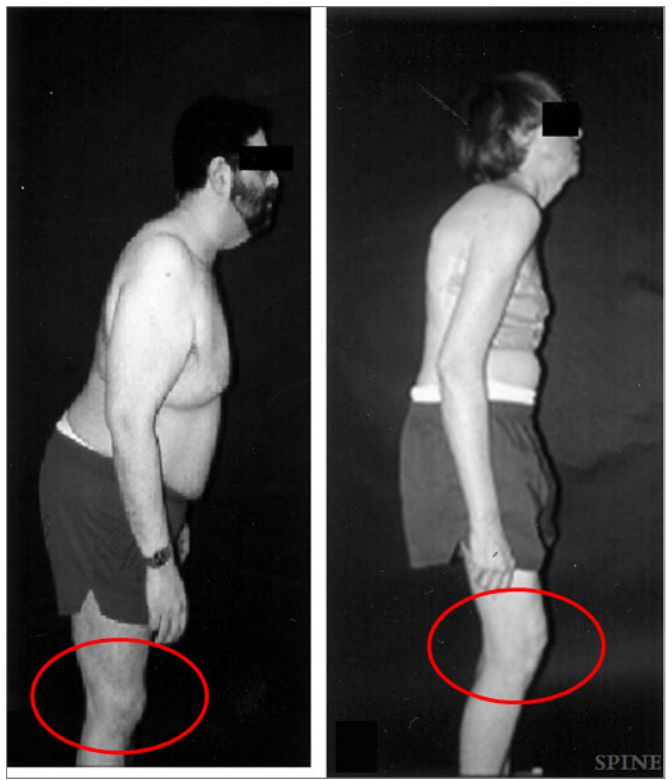
Figure 1. Standing posture in ambulatory patients with flatback: ( a ) Patient with flatback who was unable to maintain an upright posture with the knee extended fully; ( b ) Knee and hip flexion as a compensatory mechanism allows for an erect torso, protects the hip extensors and spine, but increases the demand on the quadriceps (reprinted with permission from ref. [2]. Copyright 2002 Wolters Kluwer Health, Inc., Philadelphia, USA).